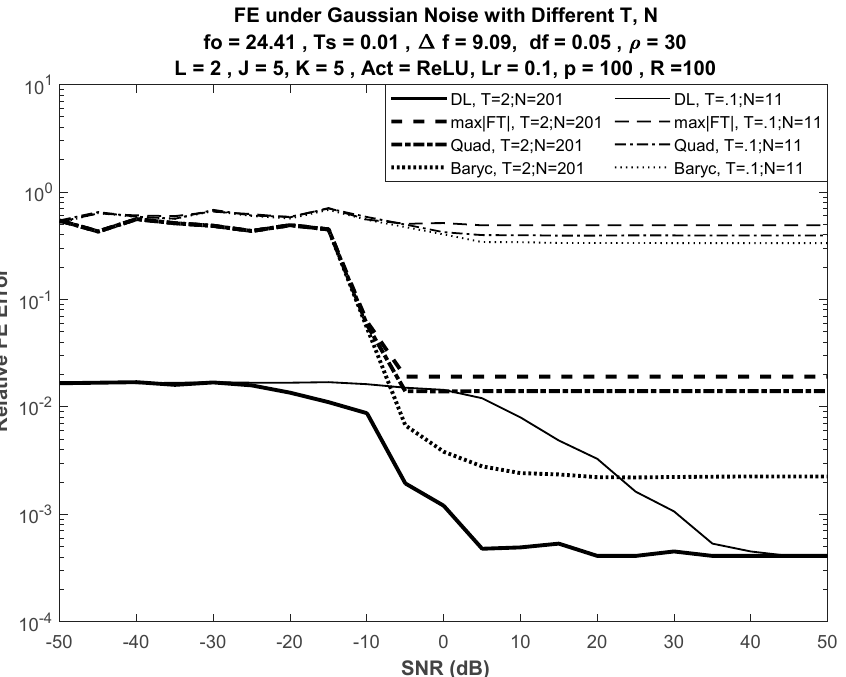
Figure 2. Performance of FE methods for different input lengths. Bold curves are for larger duration T = 2 s, N = 201 input samples; plain curves are for smaller duration T = 0.1 s, N = 11.